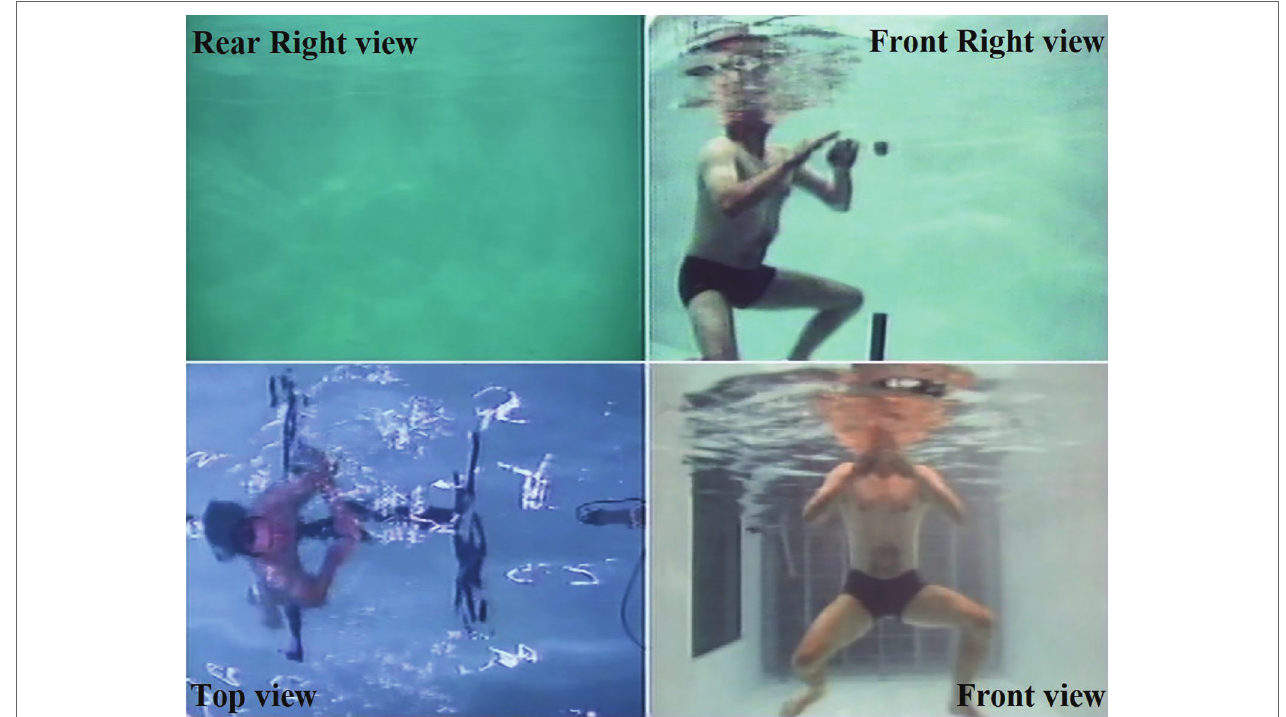
FIGURE 1 | The four synchronized camera views. The front view (bottom right image) was primarily used to determine TW pattern and movement frequency. The rear right view (top left image) was useful in instances where participants drifted from the set position and when they began swimming. These images were captured in the baseline condition. Written permission and informed consent were obtained from the depicted individual for the publication of the image.